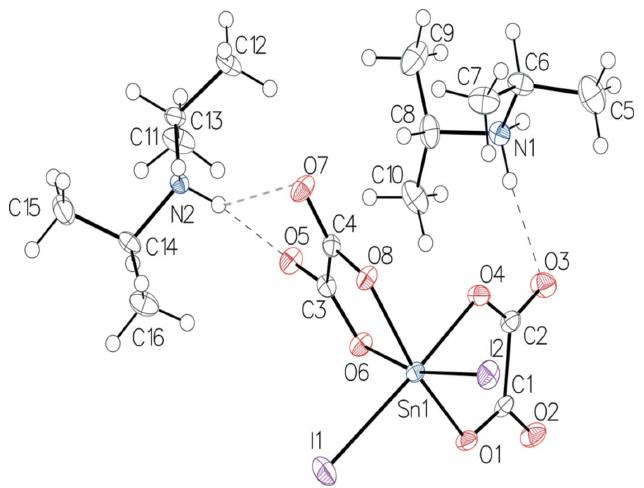
Figure 1 The molecular structure of (I), with displacement ellipsoids depicted at the 50% probability level and N—H (cid:2)(cid:2)(cid:2) O hydrogen bonds shown as dashed lines.